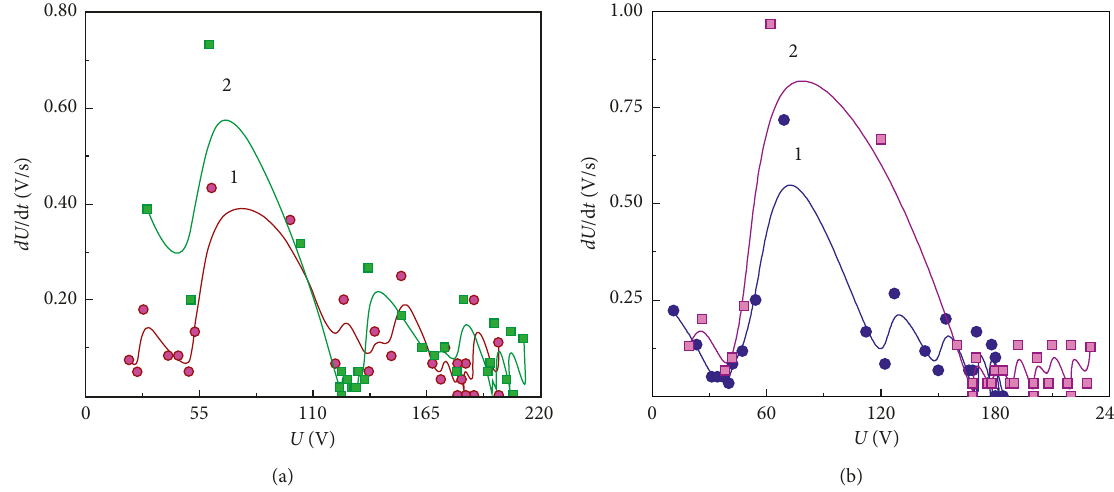
Figure 2: Rate of voltage change when forming coatings: (a) 1: TiO